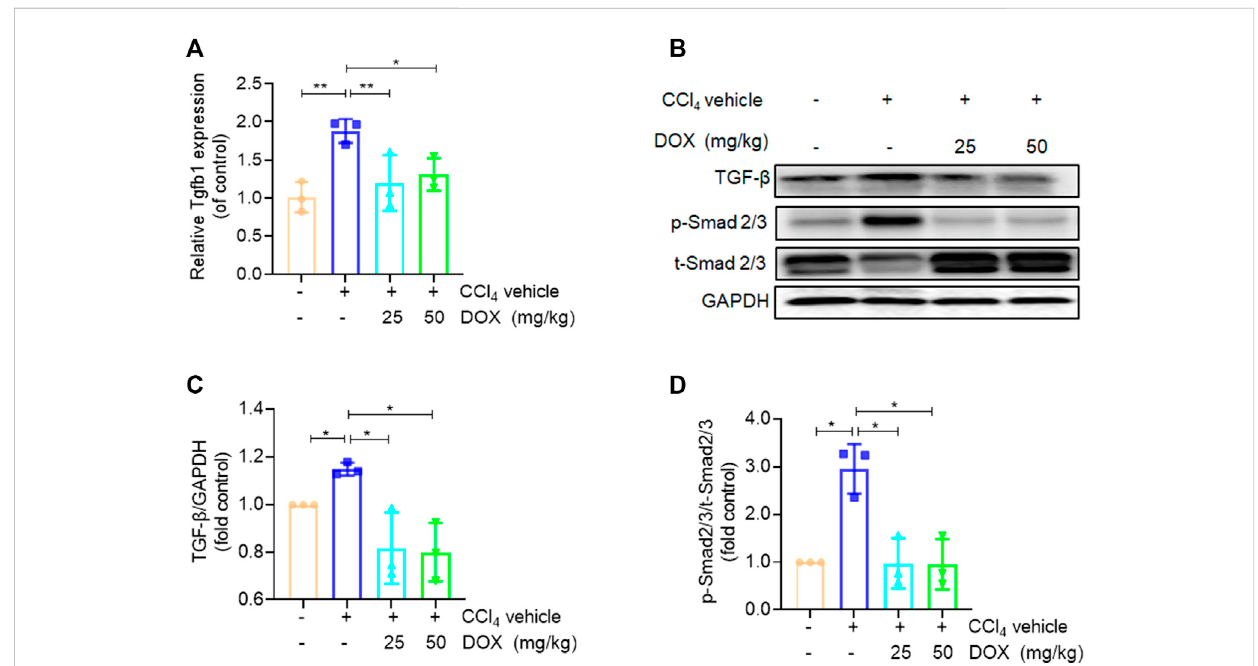
EffectsofDOXTGF- β /Smadsignalling invivo . (A) LiverTgfb1(TGF- β ),mRNAexpression( n =3). (B) TheexpressionofTGF- β ,p-Smad2/3andt-Smad 2/3 proteins inCCl 4 -induced mice liver tissues treated with DOX (25 mg/kg, 50 mg/kg) was detected by Westernblot, and GAPDH was used as a loading control.Theresultsrepresentthreeindependentexperiments. (C) ThequantitativeresultofTGF- β .Theresultsrepresentthreeindependentexperiments. (D) The quantitative result of p-Smad2/3. The results represent three independent experiments. Data were expressed as means ± SEM. * p < 0.05; ** p <